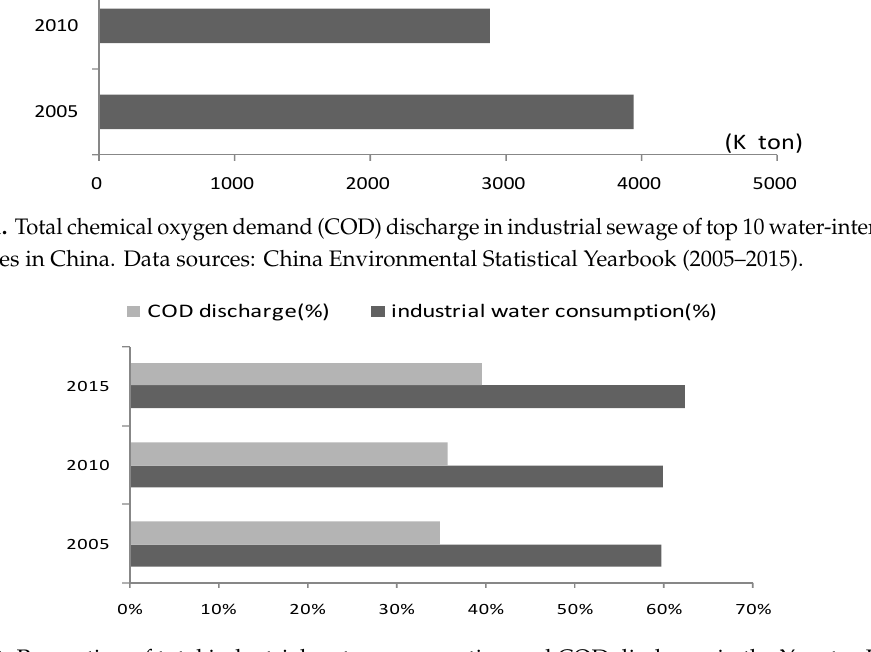
Figure 2. Proportion of total industrial water consumption and COD discharge in the Yangtze River Economic Belt (YREB) compared to nationwide. Data sources: China Environmental Statistical Yearbook (2005–2015).